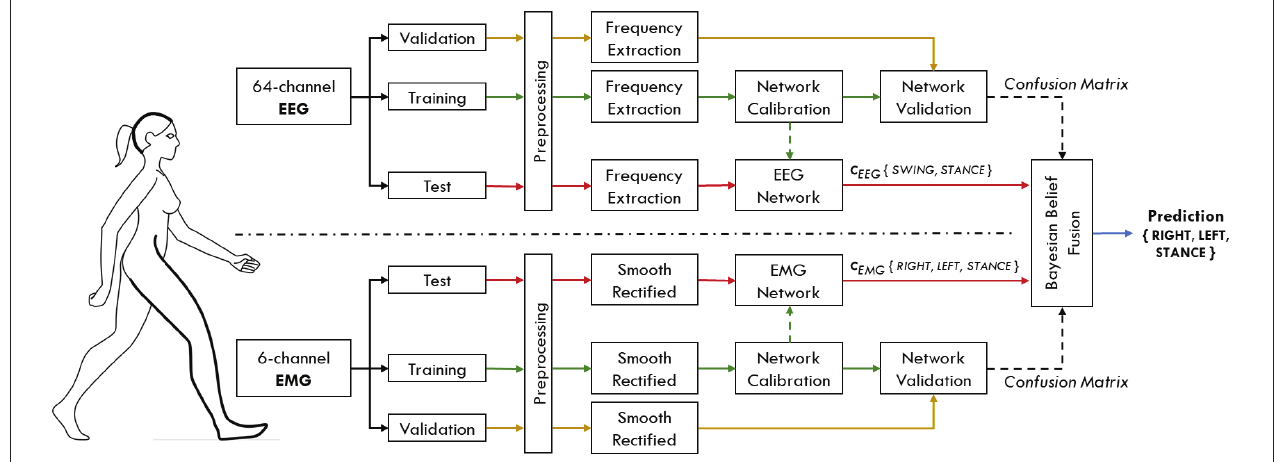
FIGURE 1 | Schematic representation of the proposed hybrid human-machine interface. Brain activity is registered with a 64-channel EEG system, while three lower limb muscles per leg are simultaneously recorded within the same acquisition set up. Each subject’s dataset is separated into three distinct groups of data, namely training, validation and test set. Data from the training set (green arrows) are used to calibrate the parameters of the two classification networks. The performance of each network, in terms of confusion matrices, are evaluated on the validation set (yellow arrows) for the EEG and EMG signals independently. These performance measures are then used to guide the Bayesian fusion method of the classifier’s output ( c EEG , c EMG ), to predict gait events on the data coming from the test set (red